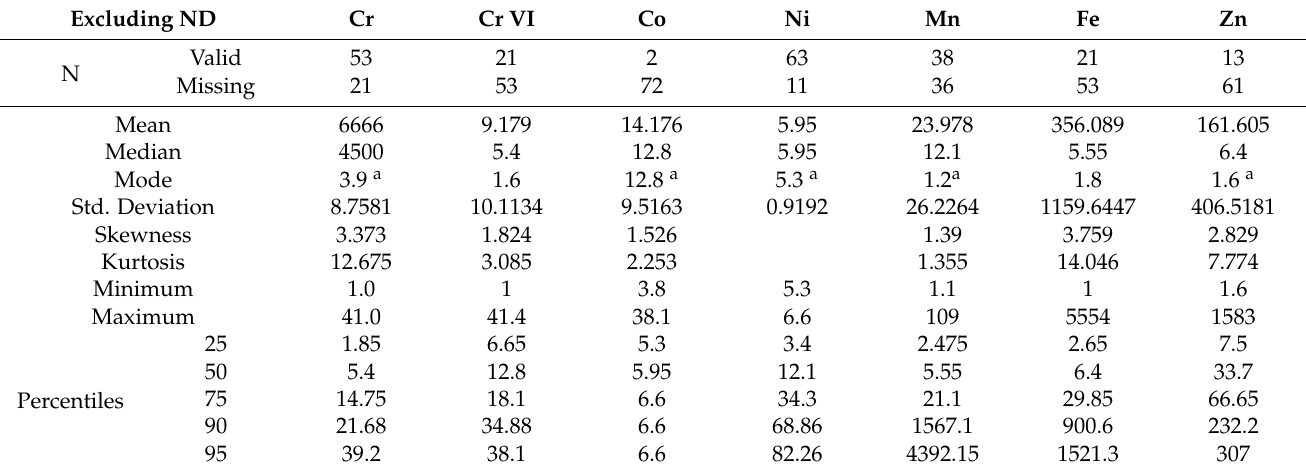
The descriptive statistics of the dataset are reported in Table 4. Concerning Co, the statistics are not relevant as this element shows only two measure- ments > LOD, both from the same MS. All the parameters have a non-normal distribution, as indicated by the non-corresponding mean and median values. The positive skewness suggests a tail extending towards high values. As for the case of the MS dataset, the mode for all parameters corresponds to the value adopted for the results < LOD (0.5 µ g/L for all PTEs except Cr VI = 1.5 µ g/L). The descriptive statistics of the dataset excluding the ND still show a positive skewness but also the presence of multiple modes (Table 5). Table 5. Descriptive statistics of the total number of PTE measurements (in µ g/L) (Table S3), excluding ND. Excluding